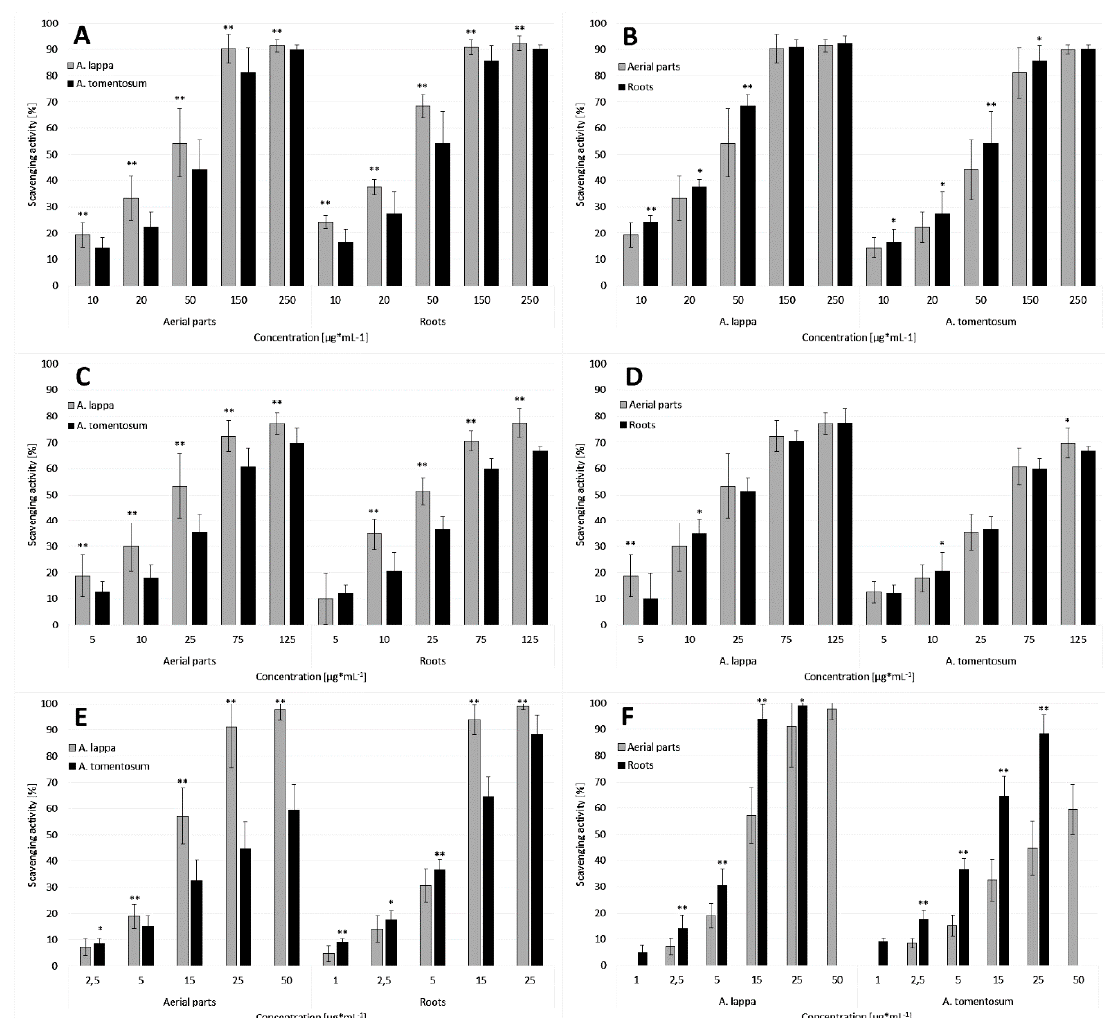
Figure 1. Average values of antioxidant activity of the extracts from the aerial parts and extracts from the roots of Arctium lappa and Arctium tomentosum . ( A , B ) DPPH scavenging activity, ( C , D ) O 2 •− scavenging activity, and ( E , F ) H 2 O 2 scavenging activity. Primes indicate statistically significant stronger activity of the particular extract at given concentration (* p < 0.05; ** p < 0.001).